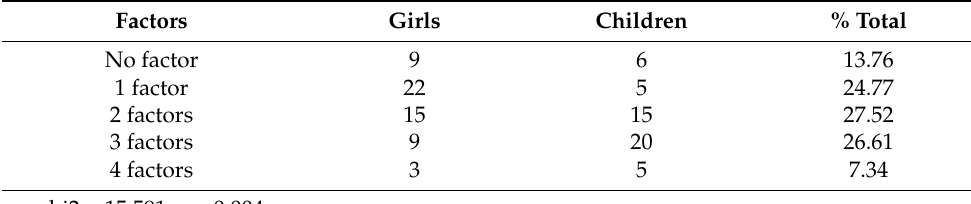
Table 4. Number of early irrigation factors accumulated by